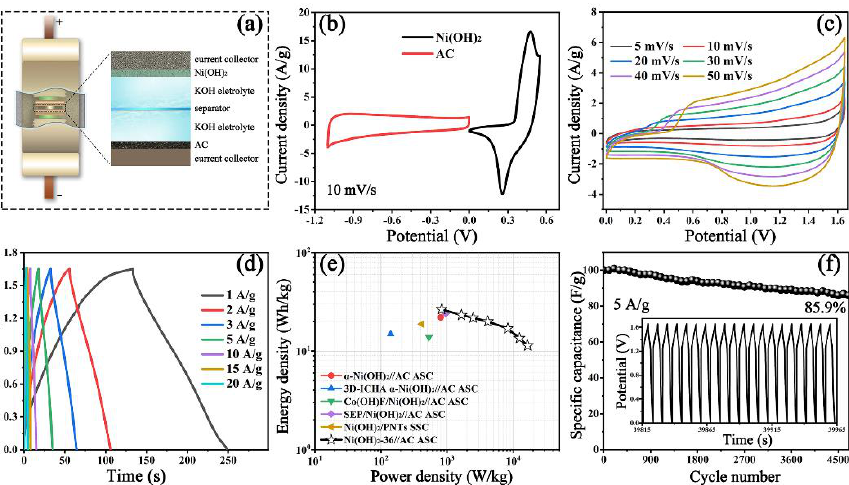
Figure 5. ( a ) Diagram of the as-prepared Ni(OH) 2 -36//AC ASC; ( b ) CV curves of the Ni(OH) 2 -36 and AC electrodes at 10 mV/s; ( c ) CV curves of the ASC at various scan rates; ( d ) GCD curves of the ASC at various current densities; ( e ) Ragone plots of the Ni(OH) 2 -36//AC ASC in contrast with other Ni(OH) 2 -based supercapacitor reported in previous reports; ( f ) cycling performance of the Ni(OH) 2 -36//AC ASC at 5 A/g (the inset shows the last 20 cycles). Table 1. Performance comparison of Ni(OH) 2 -based supercapacitors from previous reports.